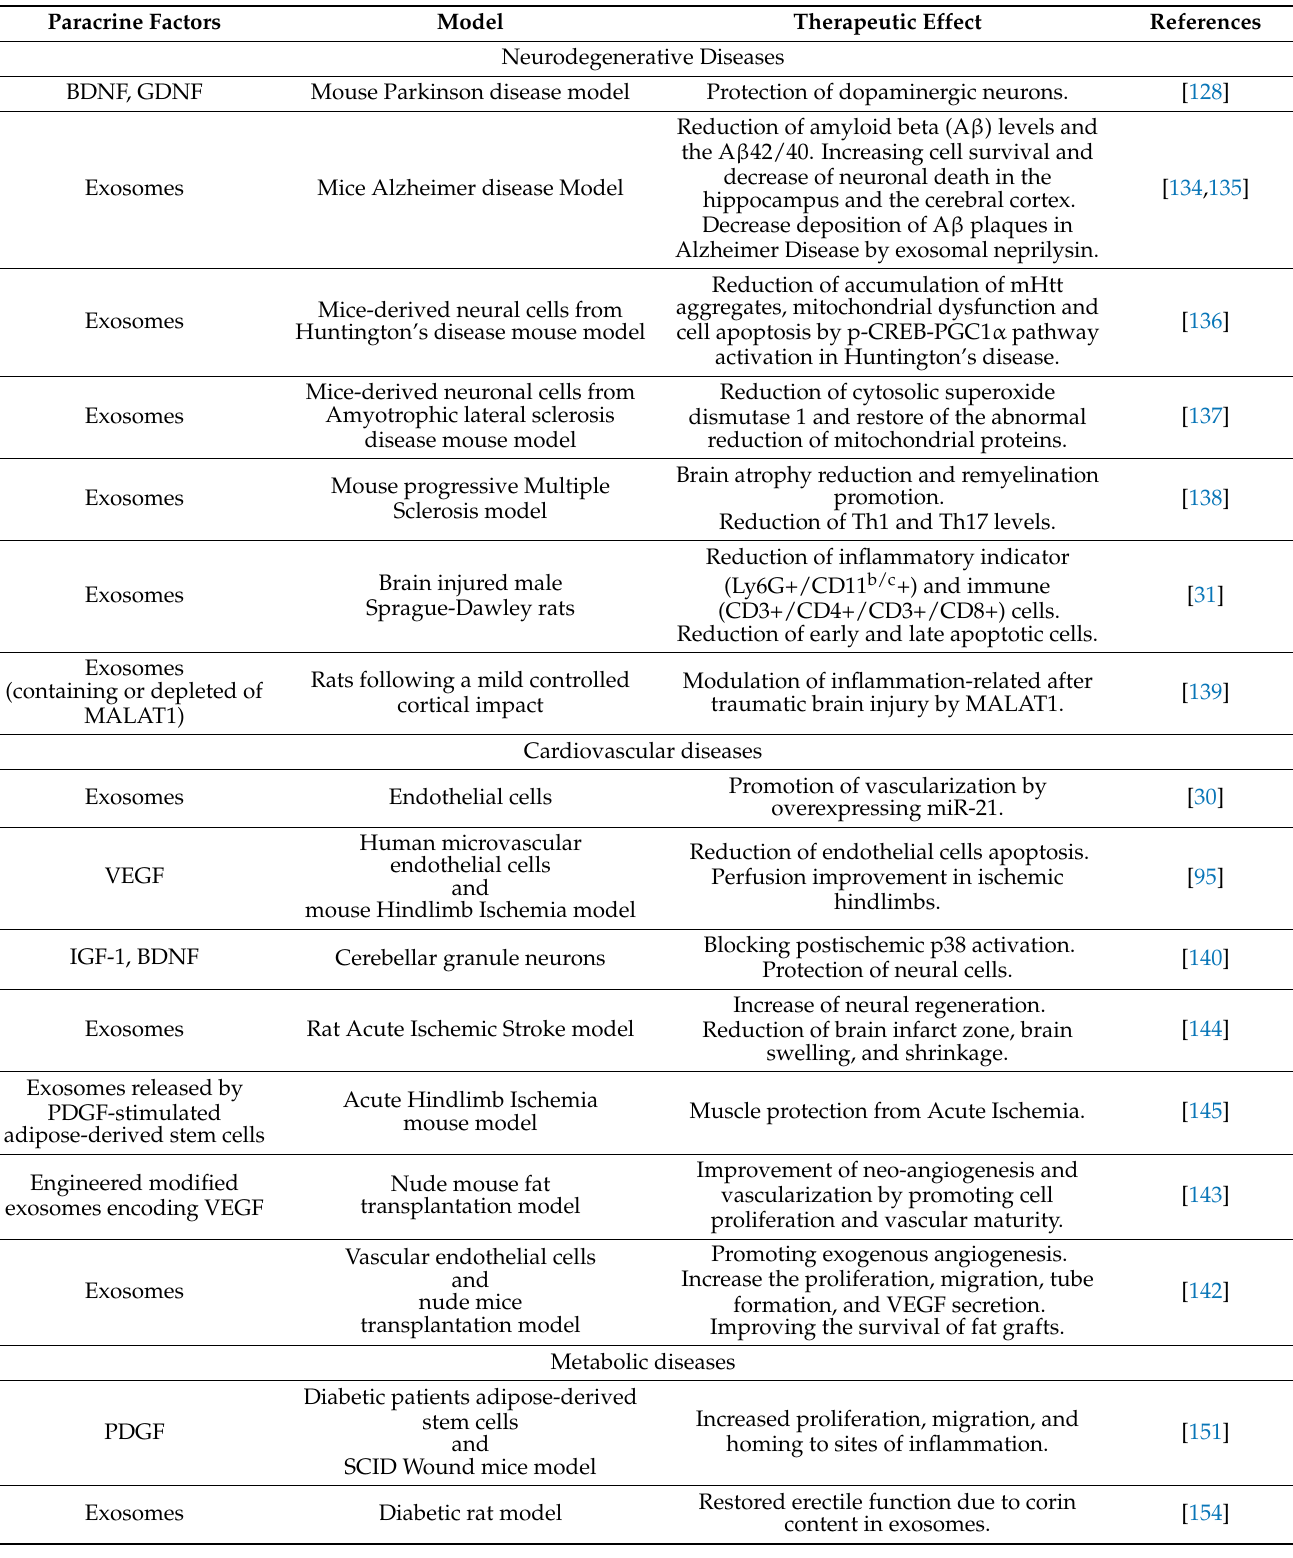
Table 2. Adipose-derived stem cells’ secretome investigations for cell-free